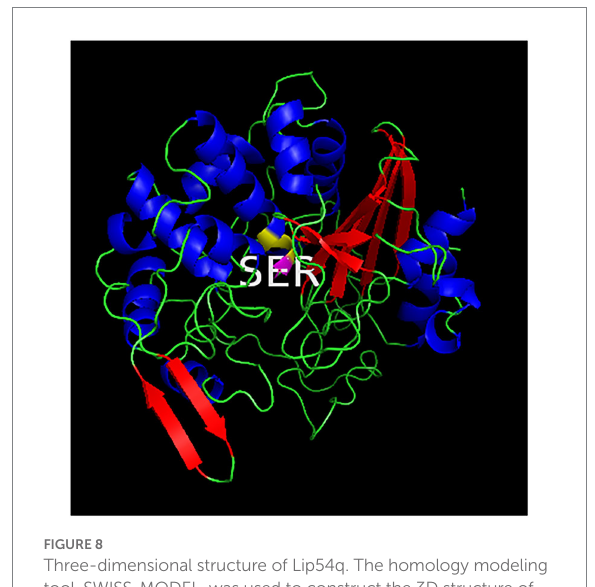
FIGURE 8 Three-dimensional structure of Lip54q. The homology modeling tool, SWISS-MODEL, was used to construct the 3D structure of Lip54q. The tertiary structure of Est-Y29 with 37.95% homology to Lip54q was use as the template for homology modeling. The blue helix represents the alpha helix structure, the red ribbon represents the β -sheet structure, and the green line represents the random coil. The active center (shown in yellow) of Lip54q contains a Ser residue.